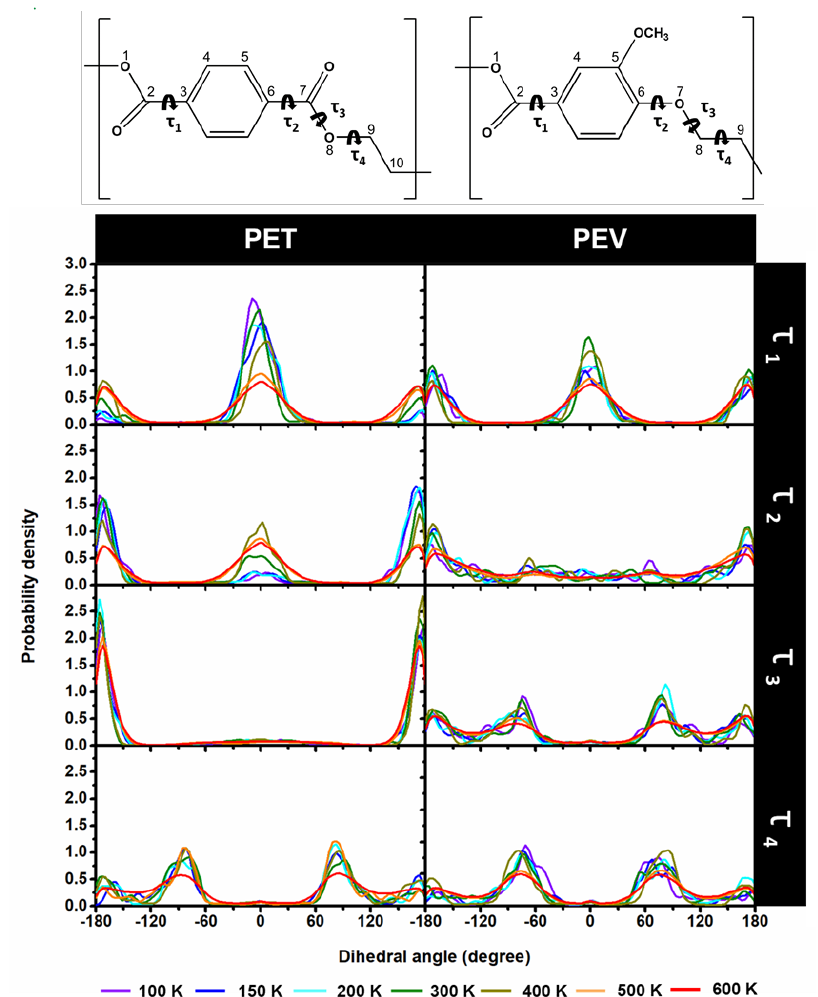
Figure 7. Distributions of the dihedral angles τ 1 (1234), τ 2 (5678), τ 3 (6789) and τ 4 (78910) of PET and PEV at different temperatures from 100 K to 600 K. The curved arrow was represents the dihedral angles.